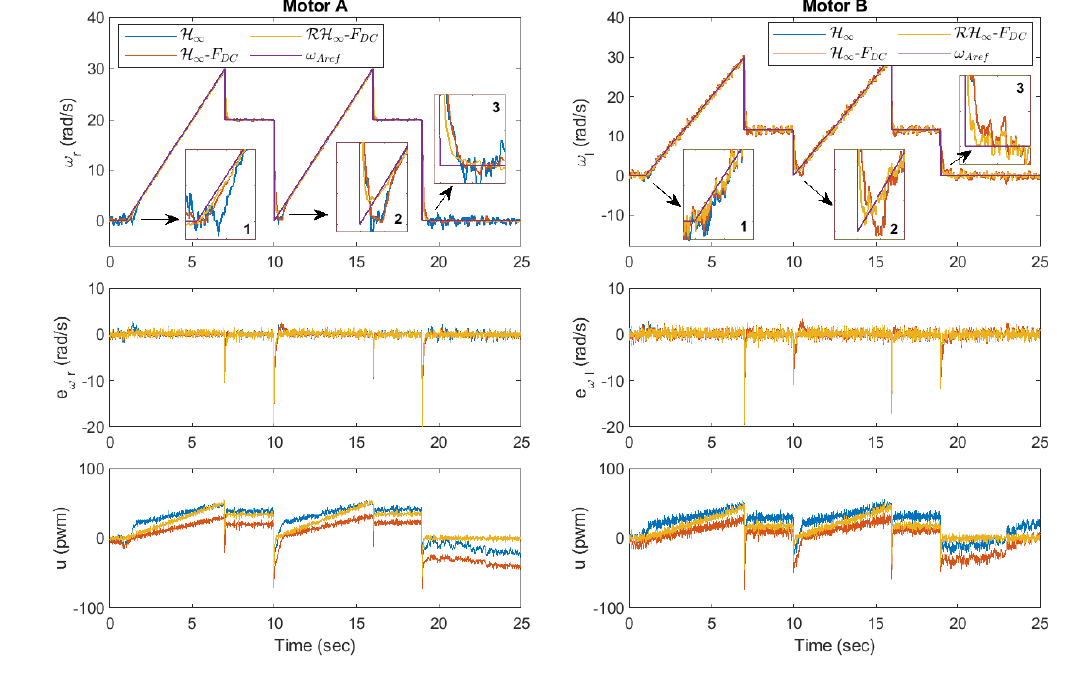
Figure 14. Exp. 2: The left column plots correspond to the time responses for Motor A while the right column plots correspond to the responses for Motor